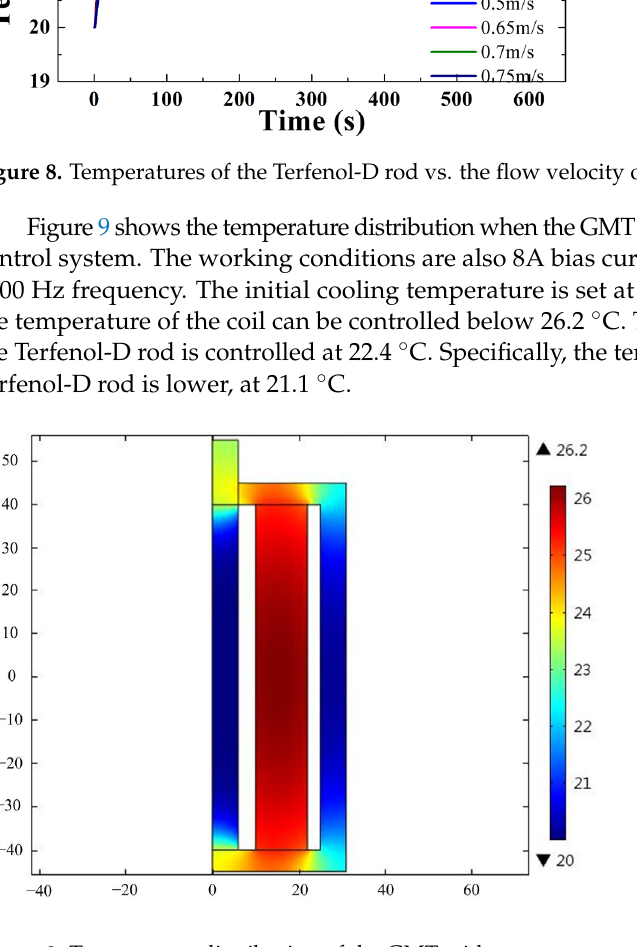
Figure 9. Temperature distribution of the GMT with temperature control.